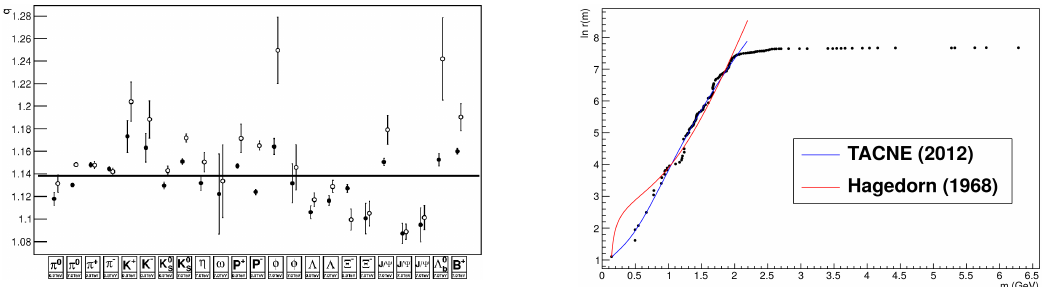
Figure 4. Left panel: Entropic index, q , obtained from a fit of the abundance of different hadron species in pp collisions using Tsallis statistics, cf. refs. [61,62]. Right panel: Cumulative hadron spectrum, as a function of the hadron mass. The dots stand for the PDG result [60]. We display also he result by using the non-extensive self-consistent thermodynamics (blue) and the result predicted by Hagedorn (red), cf. ref.